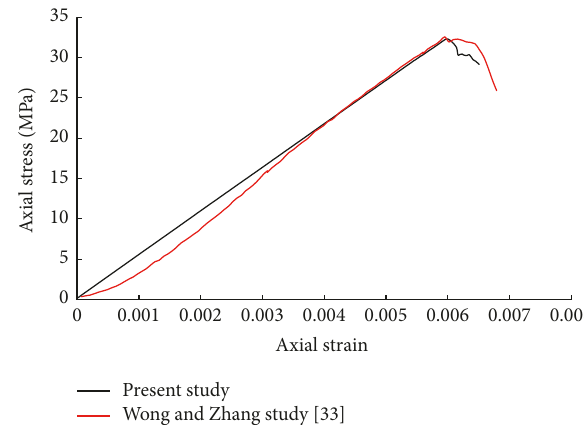
Figure 3: The stress-strain curves of the intact gypsum specimen of UDEC under uniaxial